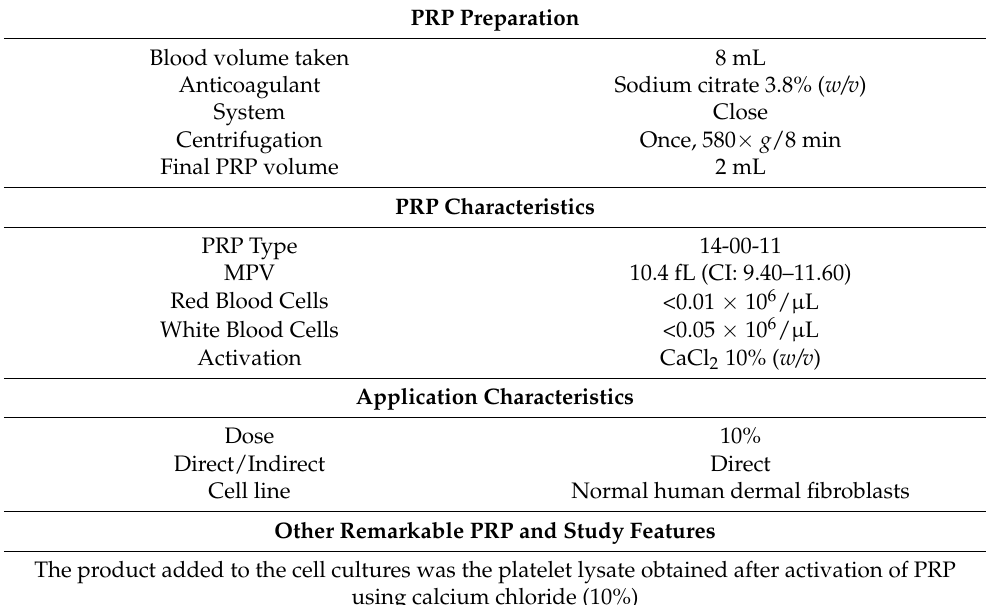
Table 1. Characteristics of